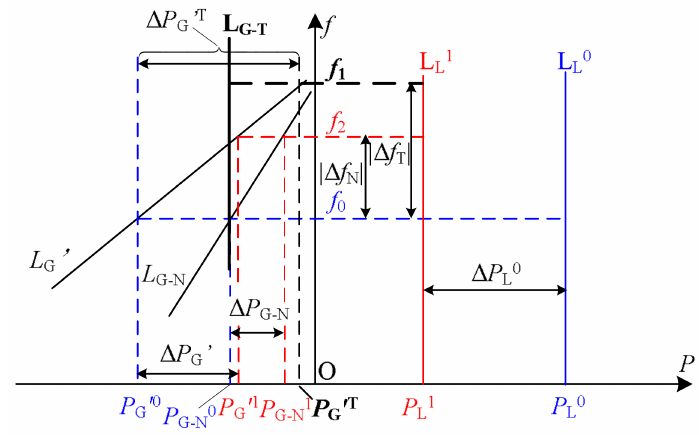
Figure 23. S-L analysis of a multi-power system including input/output bidirectional devices in the generator